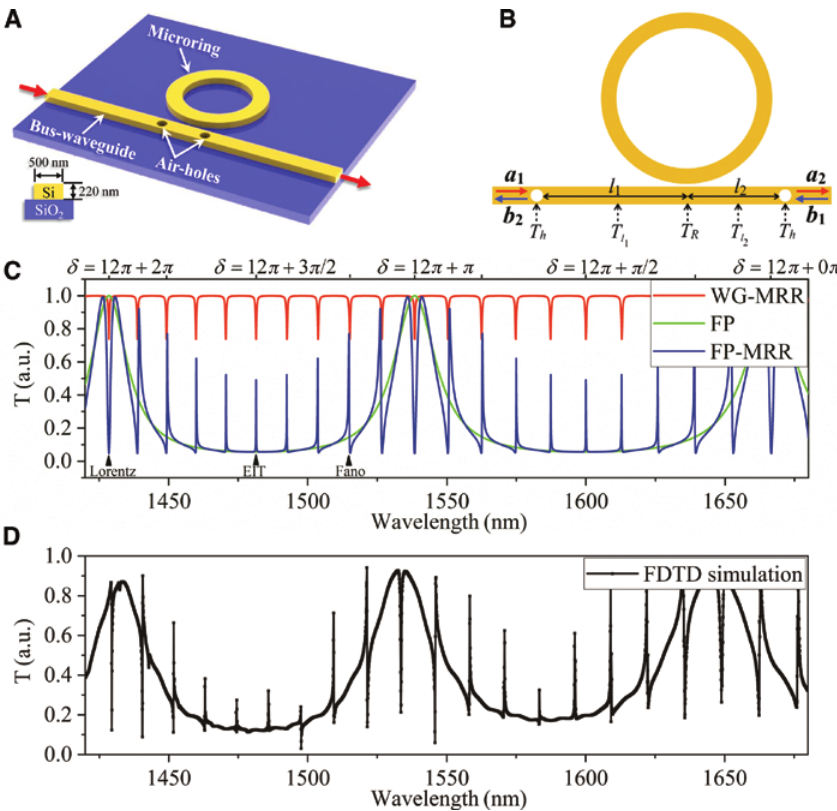
Figure 1: Models and transmission spectra of the proposed structure for realizing Lorentzian, Fano, and EIT resonance lineshapes in a MRR. (A) Schematic and (B) theoretical model of the proposed structure, where the microring resonator (MRR) is coupled with a bus-waveguide (WG) inserted with two air-holes. (C) Calculated transmission spectra of a bus-WG with two air-holes Fabry-Perot (FP), and an MRR coupled with a bus-WG with (FP-MRR) and without (WG-MRR) air-holes. (D) Simulated transmission spectrum of the FP-MRR structure using a finite difference time domain